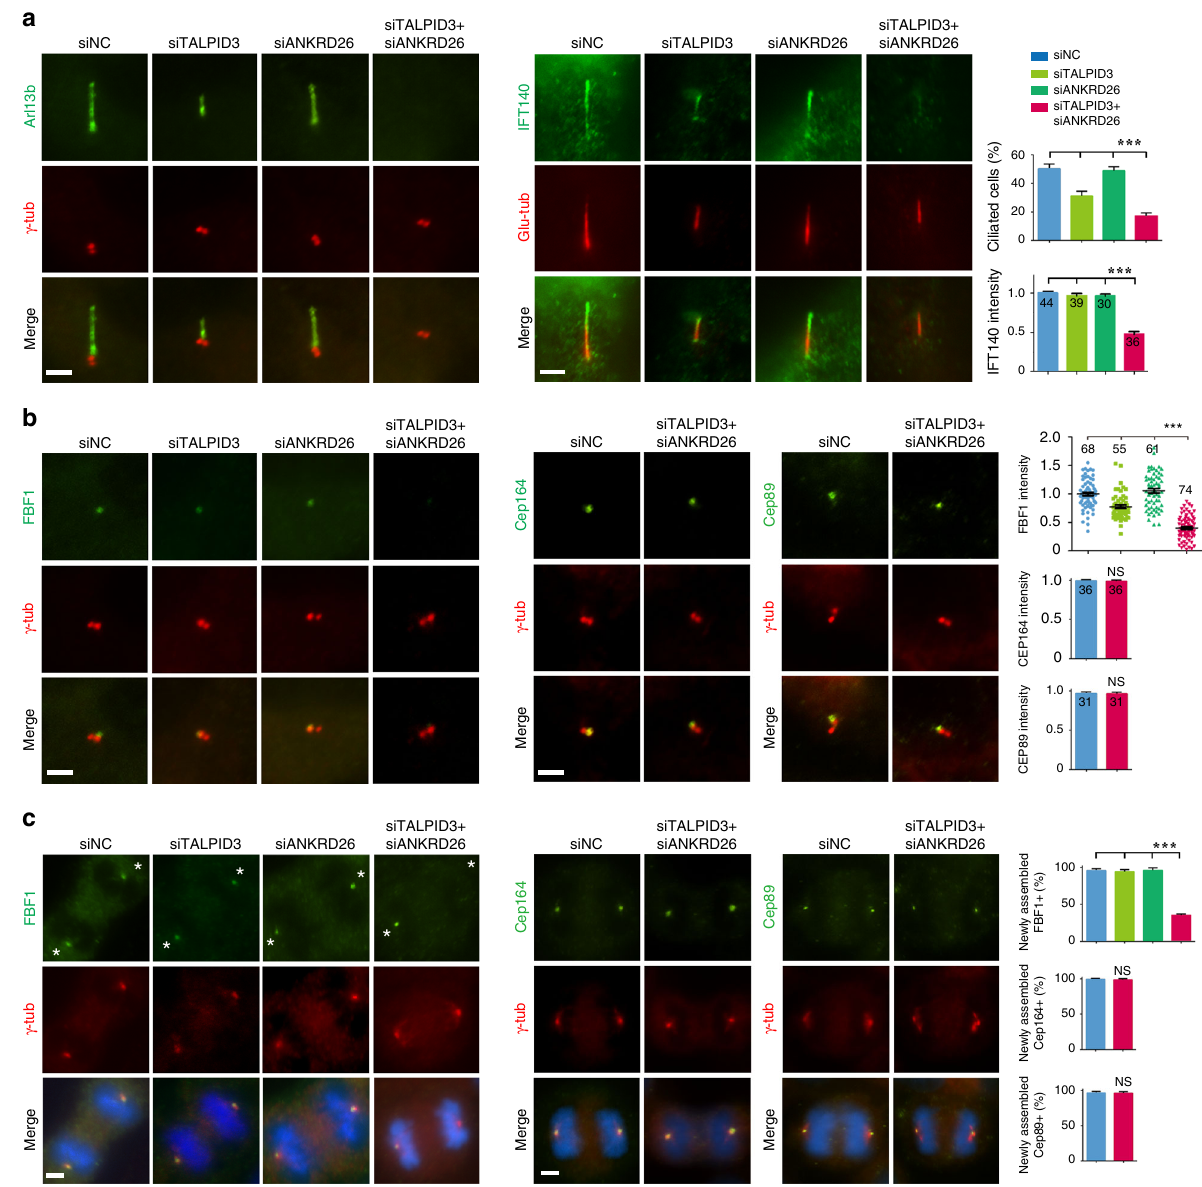
Fig. 6 The TALPID3-ANKRD26-FBF1 module plays a conserved role in mammalian cells. RPE cells were treated with negative control siRNA (siNC) or ANKRD26/TALPID3-speci fi c siRNAs (siANKRD26 and siTALPID3, respectively) for 48 h and then subjected to indirect IF with the indicated antibodies after 24 h of serum starvation. a Compared with control cells and cells depleted of only TALPID3 or ANKRD26, cells in which ANKRD26 and TALPID3 were both depleted showed signi fi cantly enhanced ciliogenesis defects and the compromised ciliary entry of the IFT component IFT140. The percentage of ciliated cells and the relative intensity of IFT140 in the cilia are shown in the right panel. For ciliated cell ratio, n = 300 cells over three independent experiments. For IFT140 intensity, numbers of cell examined are indicated in the bars. b ANKRD26 and TALPID3 co-depletion impairs FBF1 localization on the distal centriole, but does not affect the localization of CEP164 and CEP89. Quantitative data are shown in the right panel. Numbers of cell examined are indicated in the bars or above each dataset. c ANKRD26 and TALPID3 co-depletion disrupts the recruitment of FBF1 to the distal centriole during centriole mutation but does not affect the recruitment of CEP164 and CEP89. Quantitative data are shown in the right panel. n = 300 cells over three independent experiments. All data are presented as the mean ± s.e.m. Signi fi cant differences were identi fi ed by two-tailed unpaired Student ’ s t test. NS, P > 0.05; ***, P < 0.001. Scale bars, 2 μ m. Source data are provided as a Source Data fi and then incubated with His fusion protein for 4h at 4°C. After incubation, the TALP-3::VN173, and DYF-19::VC155 and ANKR-26::VN173. The paired BiFC beads were washed with binding buffer fi ve times, loading buffer was added, and the plasmids were co-injected along with the co-injection marker pRF4 [rol-6 (su1006)] beads were boiled for 10min. The samples were then subjected to SDS-PAGE and and the TZ marker MKS-5::mCherry into wild-type animals (a 15ng/ μ L con- analyzed by western blotting with monoclonal anti-His antibody. centration for each BiFC plasmid and MKS-5 plasmid and a 100ng/ μ L concentra- tion for the pRF4 plasmid). Fluorescent signals were checked using a YFP fi lter. Bimolecular fl uorescence complementation (BiFC) assay . The Venus-based Cell culture and siRNA . Human retinal pigment epithelial (hTERT RPE-1) and BiFC assay was used to examine protein interactions in living worms as described 49 . human embryonic kidney (HEK293T) cells were obtained from American Type To detect the interactions between TALP-3, ANKR-26 and DYF-19, the following Culture Collection (ATCC). RPE cells were cultured in the DMEM/F12 medium BiFC pairs were used: TALP-3::VC155 and ANKR-26::VN173, DYF-19::VC155 and